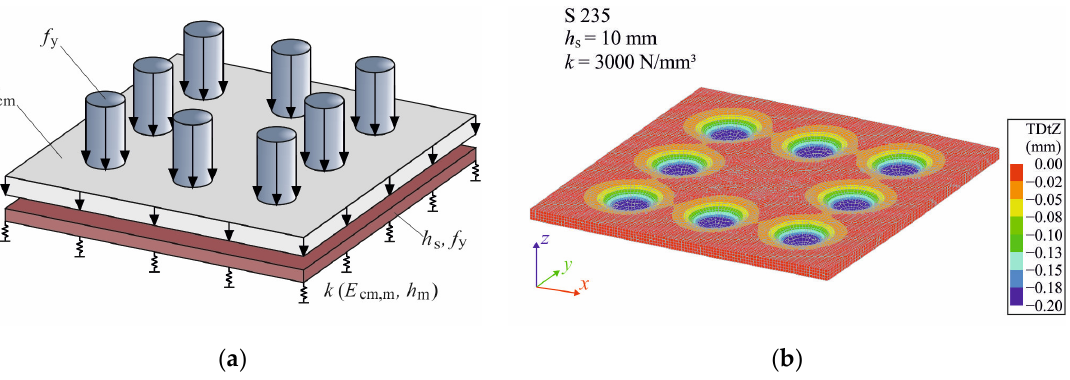
Figure 10. ( a ) FE model of elastically supported steel plate; ( b ) exemplary deformation plot.